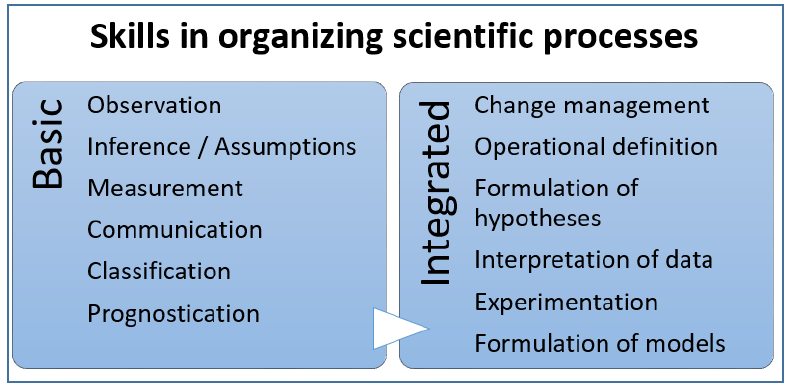
Figure 7: Skills in organizing scientific